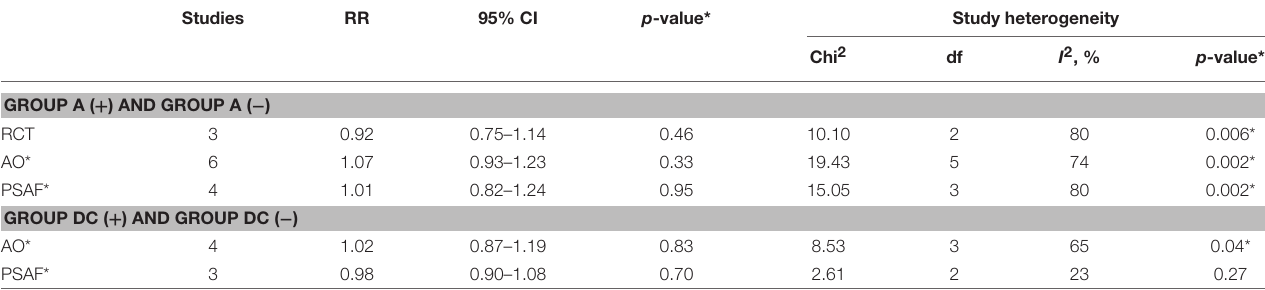
Table 4 | Results of sensitivity